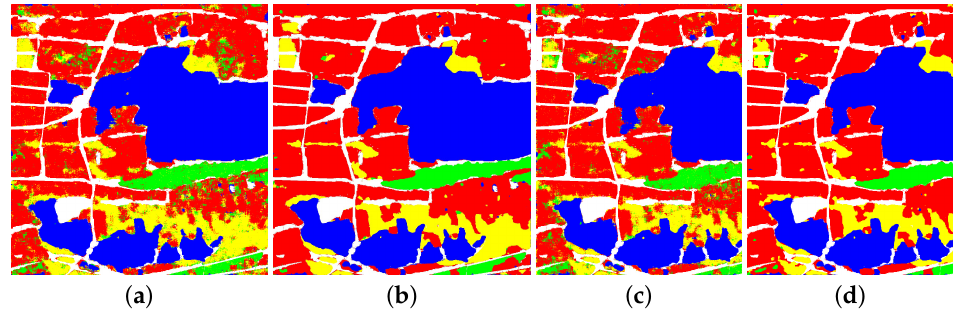
Figure 10. The classification result of GF-3 Wuhan. ( a ) Lenet-5, training with Samples 1; ( b ) FFS-CNN, training with Samples 1; ( c ) Lenet-5, training with Samples 2; ( d ) FFS-CNN, training with Samples